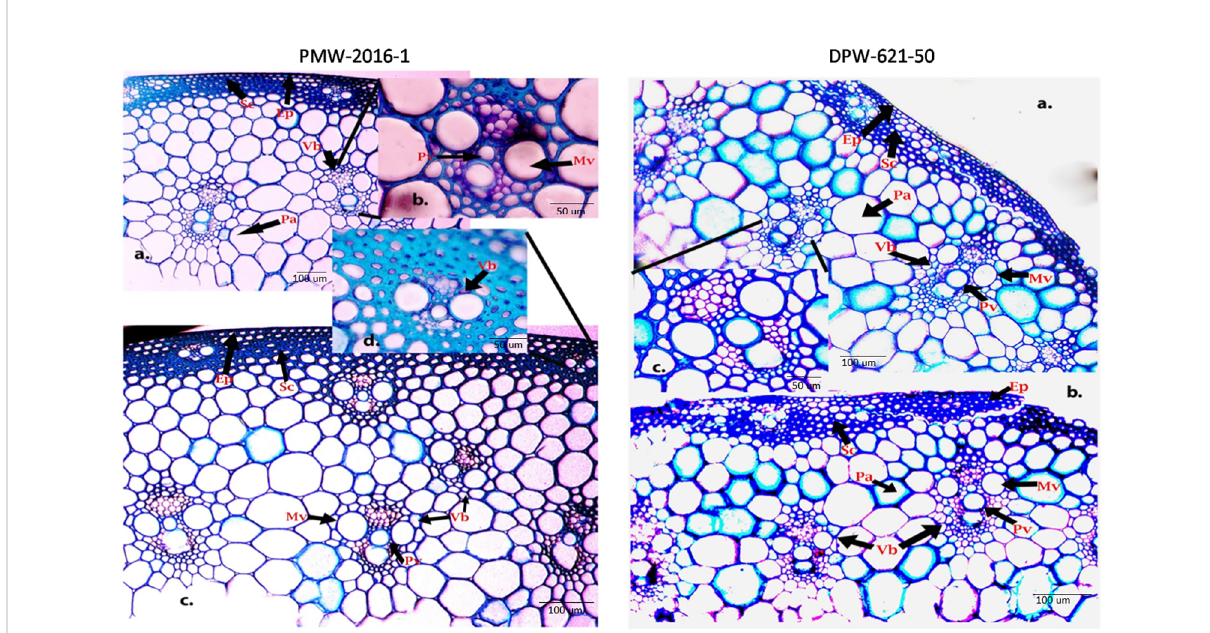
FIGURE 2 Toluidine blue- O staining of PMW-2016-1 (A-D) and DPW-621-50 (A-C) stem sections showing lignin deposition in the walls of sclerenchyma, Protoxylem and Metaxylem cells (A-C) . The positions of the Protoxylem (Pv), Metaxylem (Mv), Sclerenchyma (Sc), Parenchyma (Pa), Epidermis (Ep), Vascular bundles (Vb) are indicated.